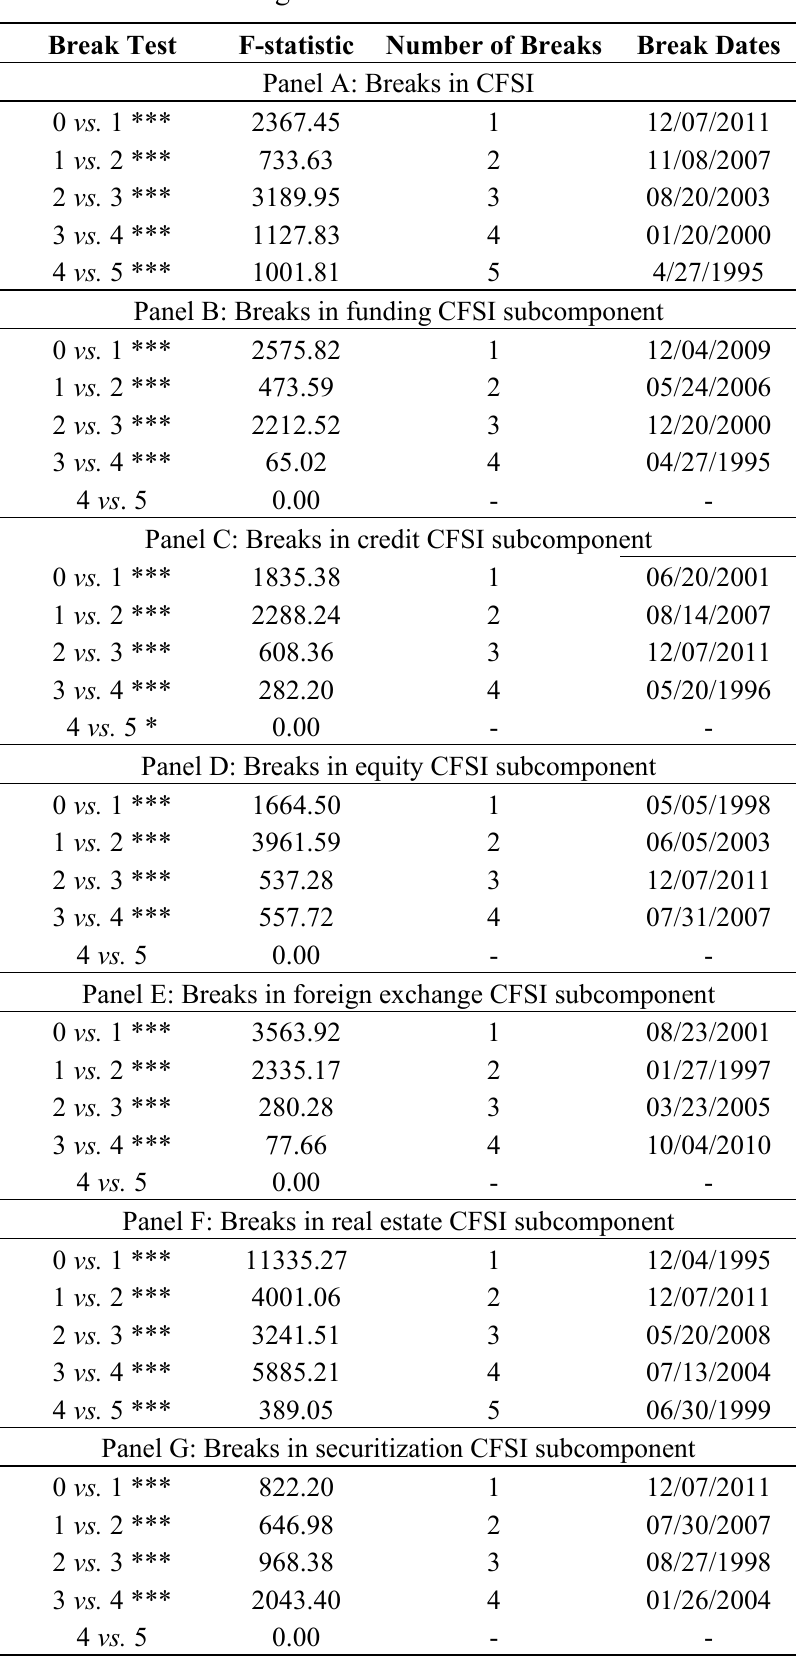
Table 6. Bai-Perron testing for structural breaks in CFSI and its markets. Break Test F-statistic Number of Breaks Break